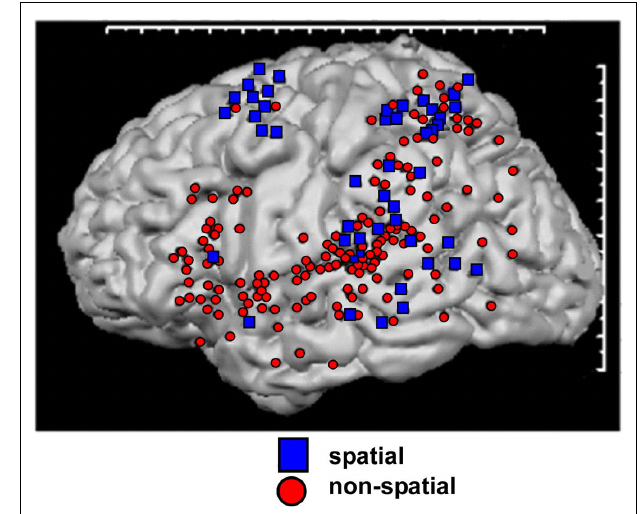
FIGURE 2 | Schematic representation of auditory pathways as evidenced by a meta-analysis of 11 spatial ( dorsal ) and 27 non-spatial ( ventral ) studies. Regions showing greatest activation in each study are indicated. Adapted from Arnott et al. (2004) with